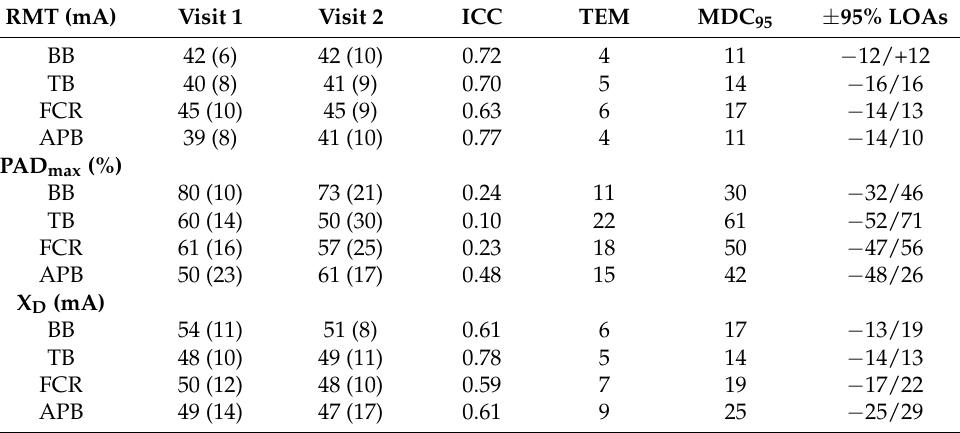
Table 1. Group means (SDs) of stimulation characteristics derived from Visit 1 and Visit 2 inten- sity/response curves. Relative (ICC) and absolute (TEM and 95% LOAs) measures of reliability are also presented for resting motor threshold (RMT), maximal post-activation depression (PAD max ) and the current at which PAD max occurred (X D